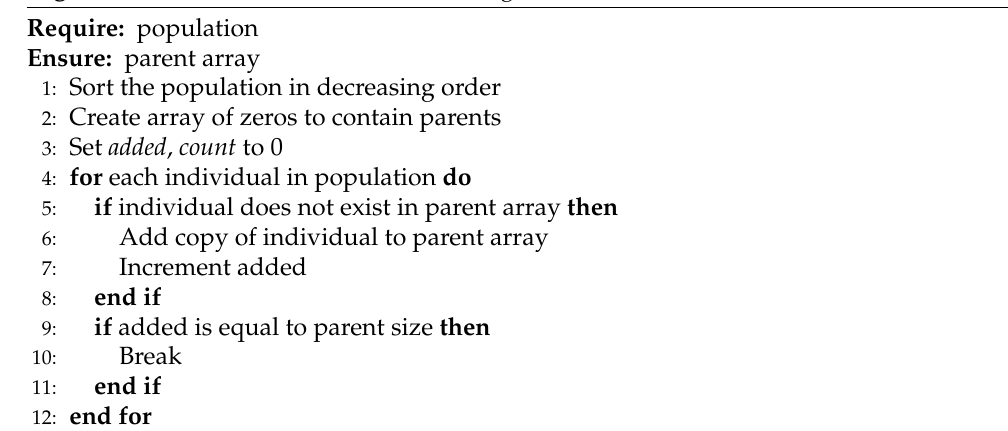
Algorithm 1 Pseudocode of the selection